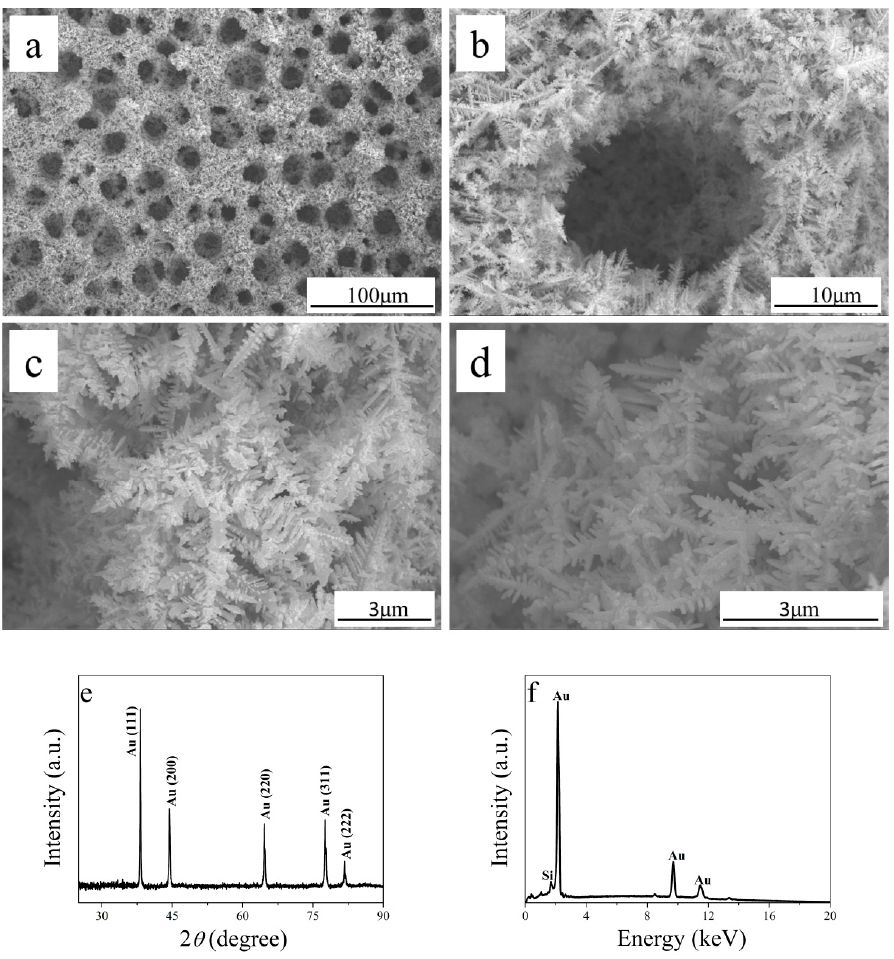
Figure 1. SEM images of ( a ) Au foam, ( b ) magnified view of ( a ), ( c ) pore wall, and ( d ) inner pore; ( e ) XRD pattern and ( f ) energy-dispersive X-ray spectroscopy (EDS) spectrum of Au foam.